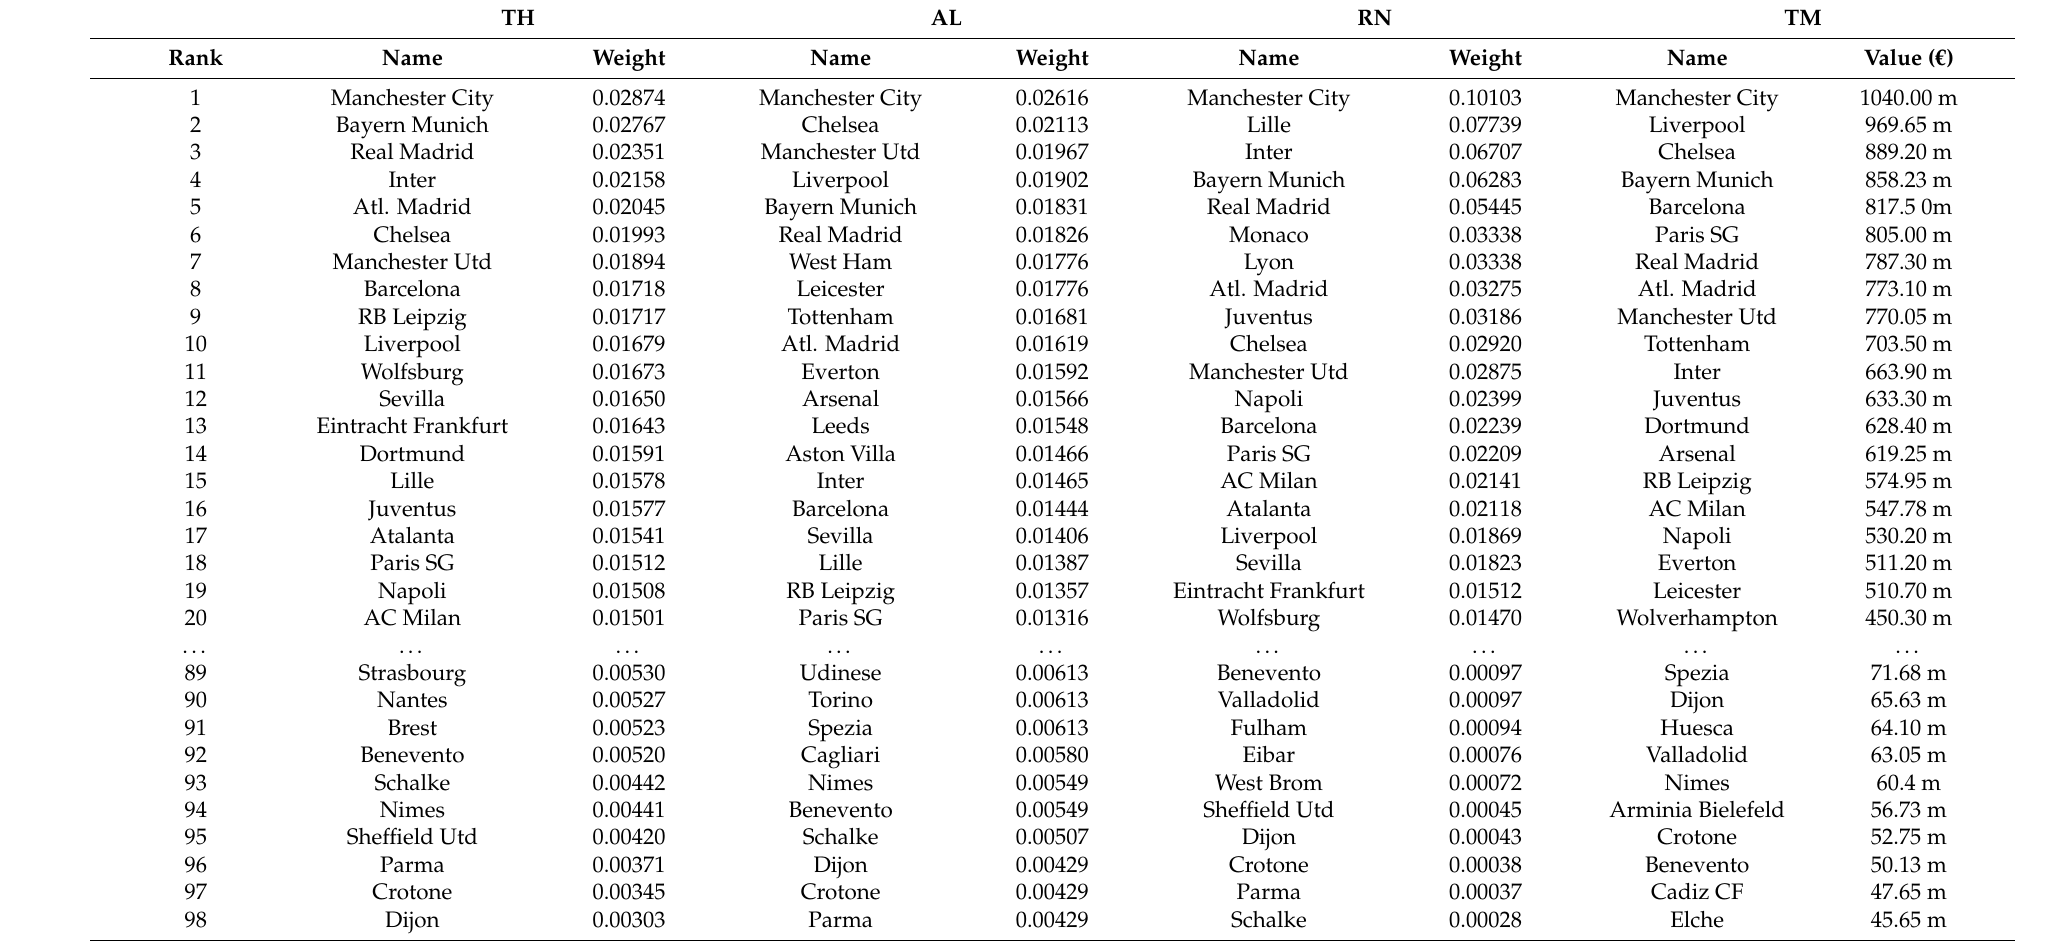
Table 3. Rankings after aggregation, taking into account the international matches with W = 1